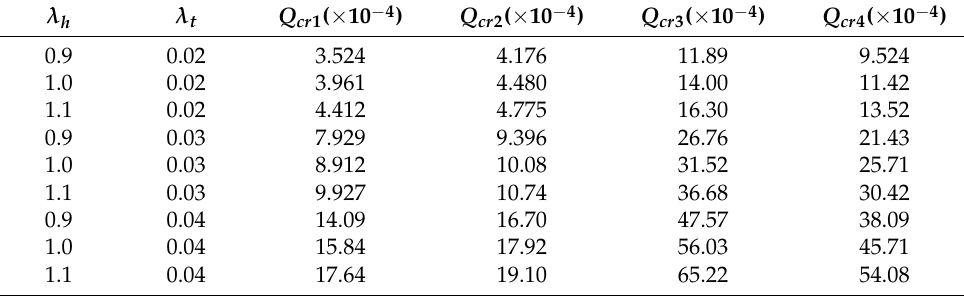
Table 3. Four critical loads under different λ h and λ t ( β = ± 0.05